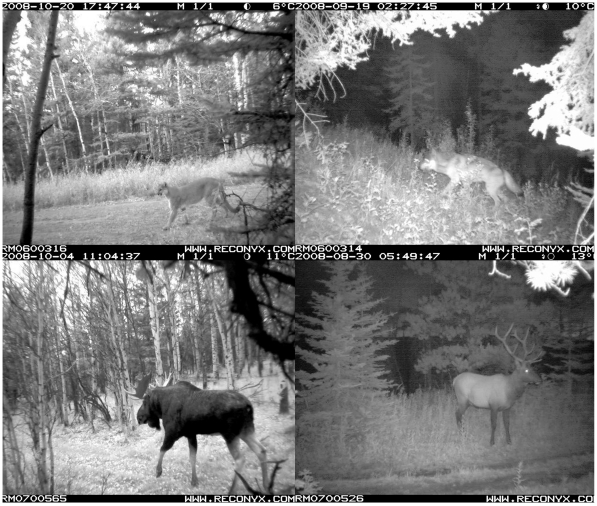
A sample of photos taken by cameras deployed on roads and trails in southwest Alberta, Canada during the summer of 2008.We photographed all large mammalian species in southwest Alberta, also including: cougar (top left), wolf (top right), moose (bottom left) and elk (bottom-right).